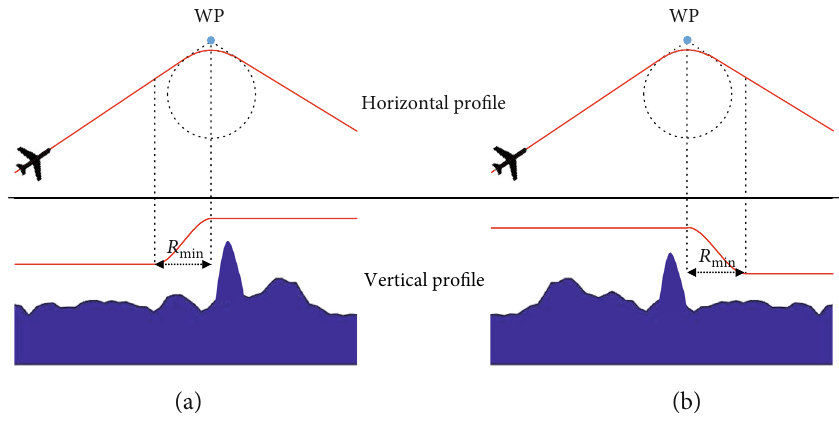
Figure 14: Three-dimensional path smoothing: (a) ascending trajectory; (b) descending trajectory. Table 1: UAV fl ight characteristics.